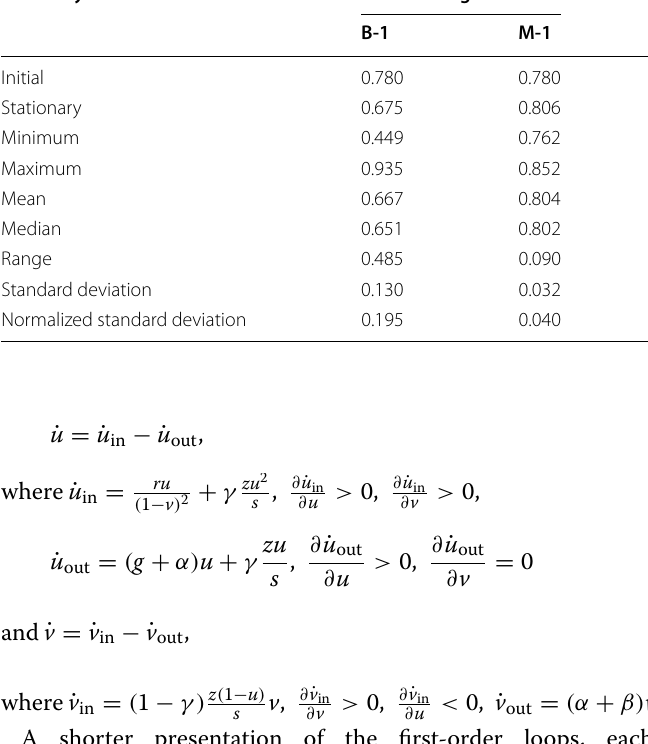
Table 3 Statistics for relative wage u and employment ratio v in B-1 and M-1, years 0–200 Summary